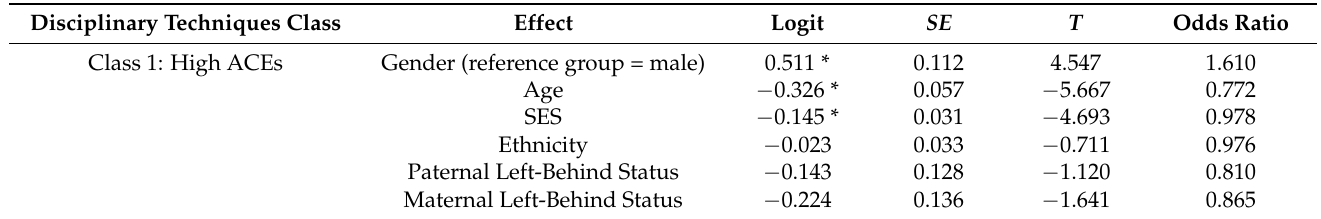
Table 3. Log odds coefficients and odds ratio for the three-class model with demographic variables as covariates using the Class 3: Low ACEs class as the comparison